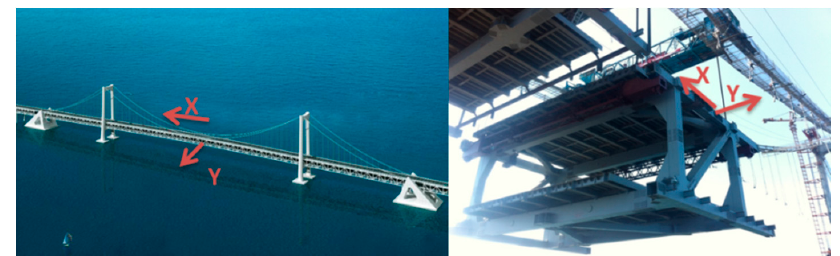
Figure 12. Specified directions.